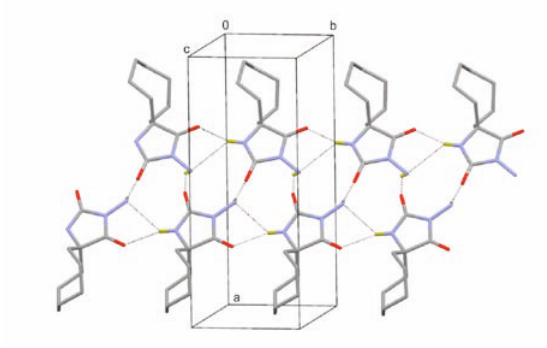
Figure 3. A view of the double chain interaction in (II). Hydrogen bonds are represented by dotted lines. All H atoms, except those involved in hydrogen bonding interactions, have been omitted.